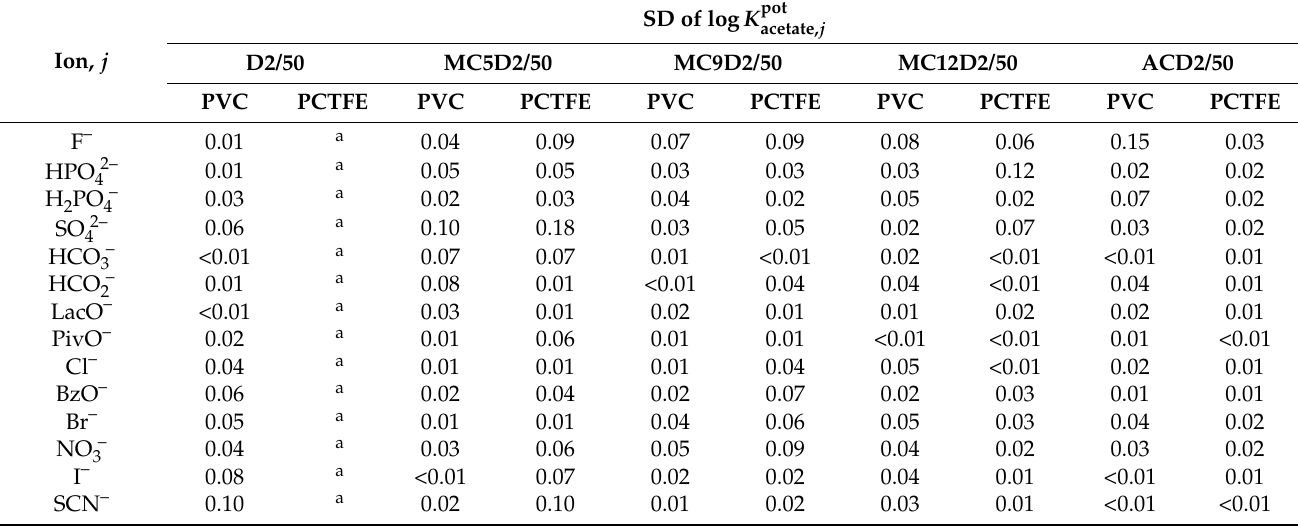
Table A8. Standard deviations for the average selectivity coefficients in Table A7. The number of measurements and the number of sensors were n = 1 and k = 2, respectively, unless noted otherwise. See Table 1 for membrane